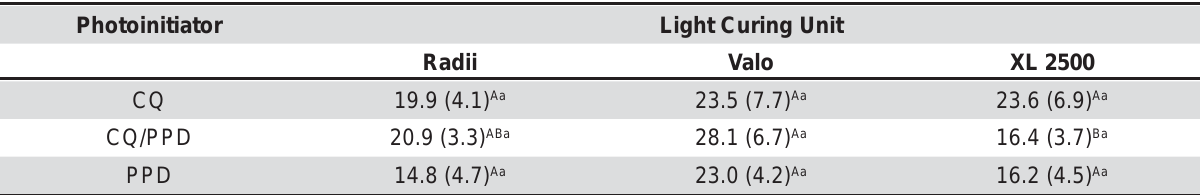
Table 4- Mean KNH value (Kgf/mm 2 ) and standard error (±) provided for each of the photoinitiator systems Photoinitiator